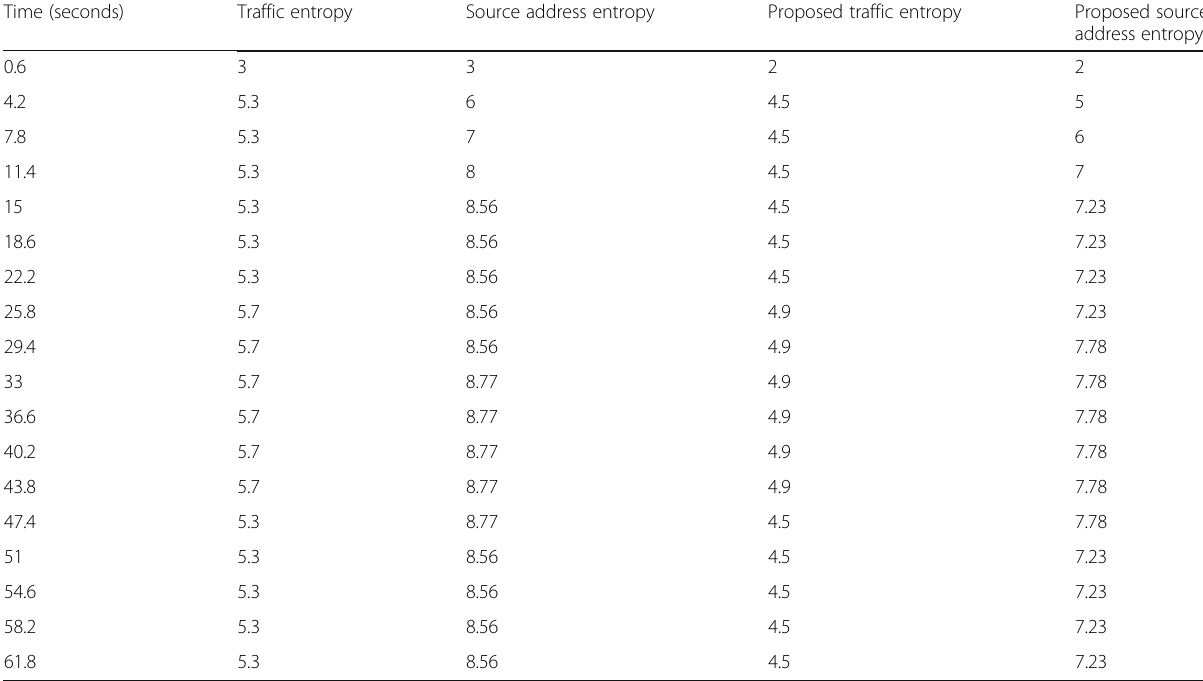
Table 6 Variation in entropy during normal web traffic with non-spoofed DDoS attacks. The dynamics of source address and traffic entropies are recorded against different times Time (seconds) Traffic entropy